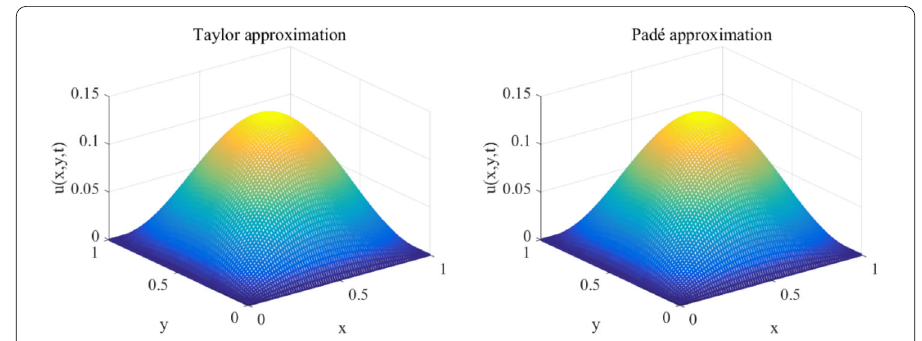
Figure 14 The numerical solutions of the CFDS-PIM of the Taylor approximation (on left-hand side figure) and the numerical solutions of the CFDS-PIM of Padé approximation (on right-hand side figure) for two-dimensional problem at t = 0.1 with N = 81 × 81 for case 2 of Example 4